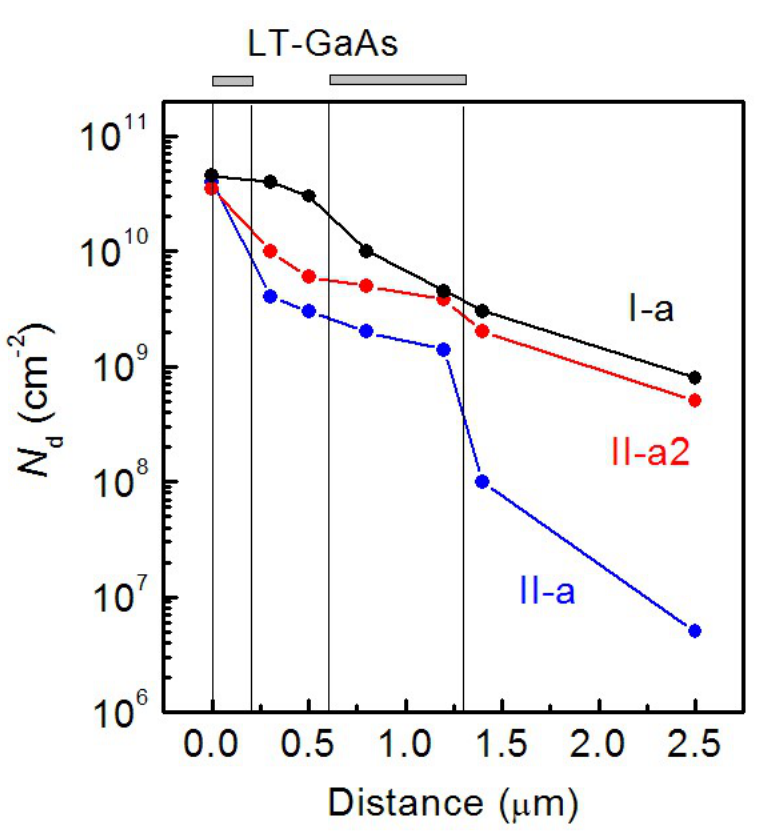
Figure 4. TD density dependences on the distance along the growth axis for I-a (black line-dots), II-a (blue line-dots) and II-a2 (red line-dots) GaAs/Si HSs. The LT-GaAs layer positions are indicated with vertical lines.